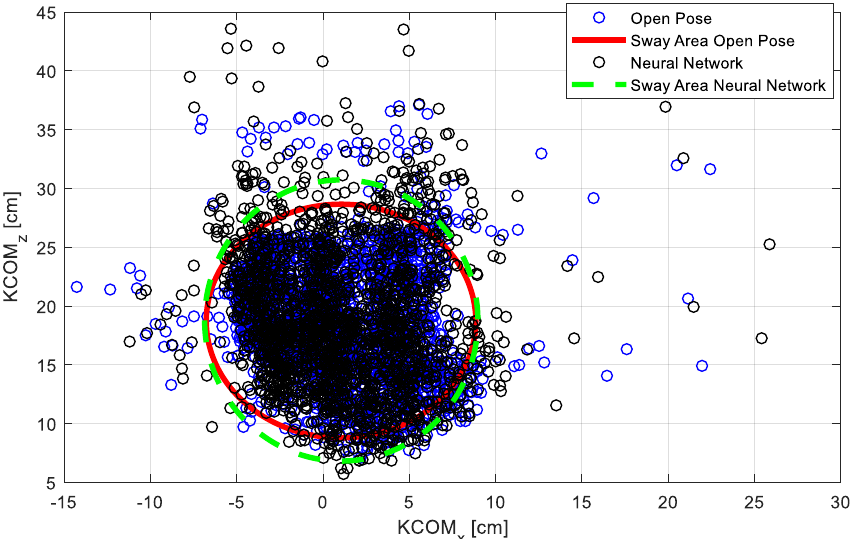
Figure 11. Dispersion of points obtained thanks to OpenPose software compared with the neural network results (for acquisition 1).